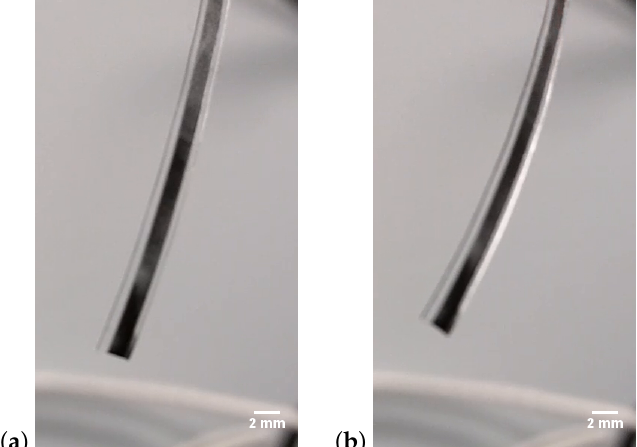
Figure 11. ( a ) Representative single stacked actuator fabricated using Method I. ( b ) Microfabricated actuator in its actuated state.